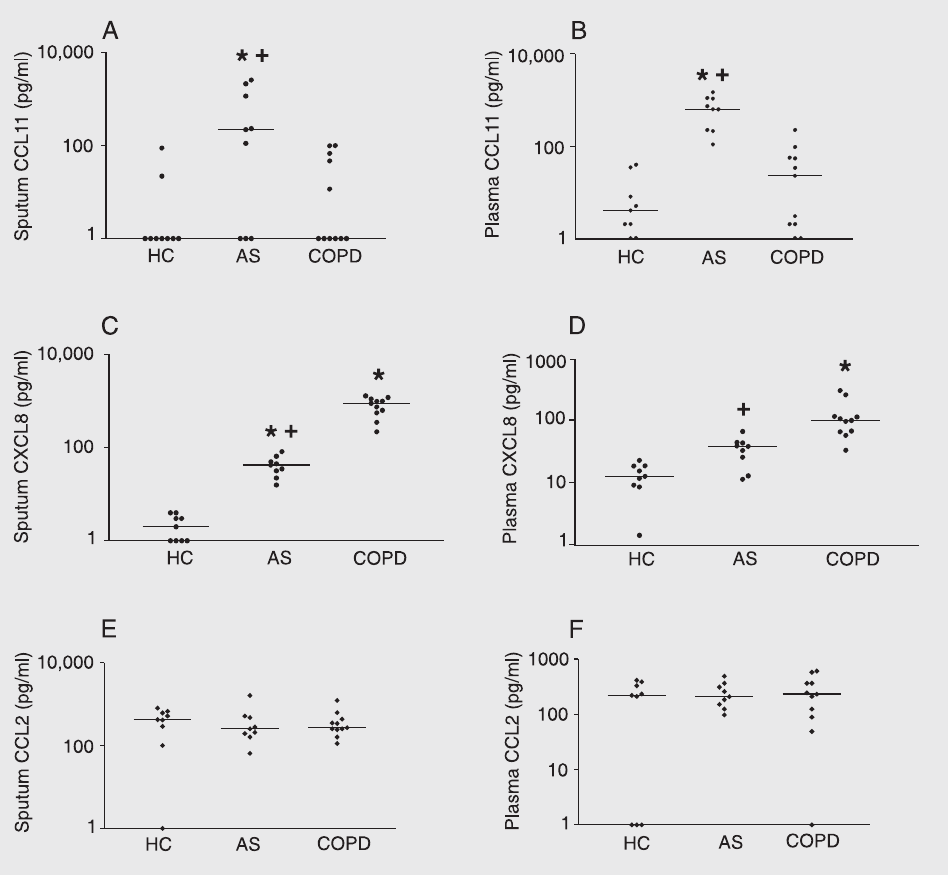
Figure 2. Concentrations of TNF- α and CCL3 in sputum of healthy controls (HC, N = 9) and patients with asthma (AS, N = 9) or chronic obstructive pulmo- nary disease (COPD, N = 11). The concentration of TNF- α (A) and CCL3 (B) in sputum was measured by ELISA. Data are reported as the log mean value. The horizontal lines indicate the median value for each group. *P < 0.05 compared to HC and + P < 0.05 compared to COPD (Spearman’s rank correlation